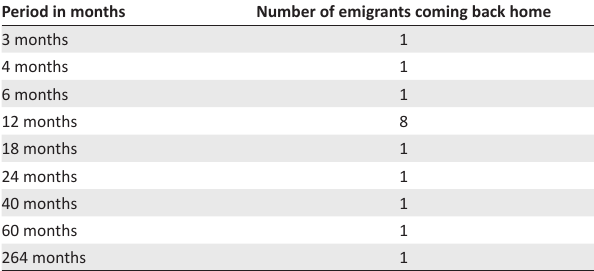
TABLE 2: Emigrants’ frequency of coming back